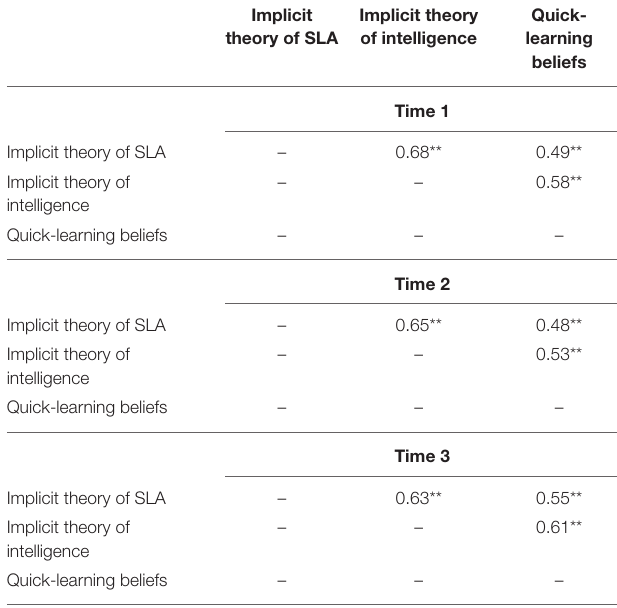
TABLE 1 | Correlations between the belief measures at each time